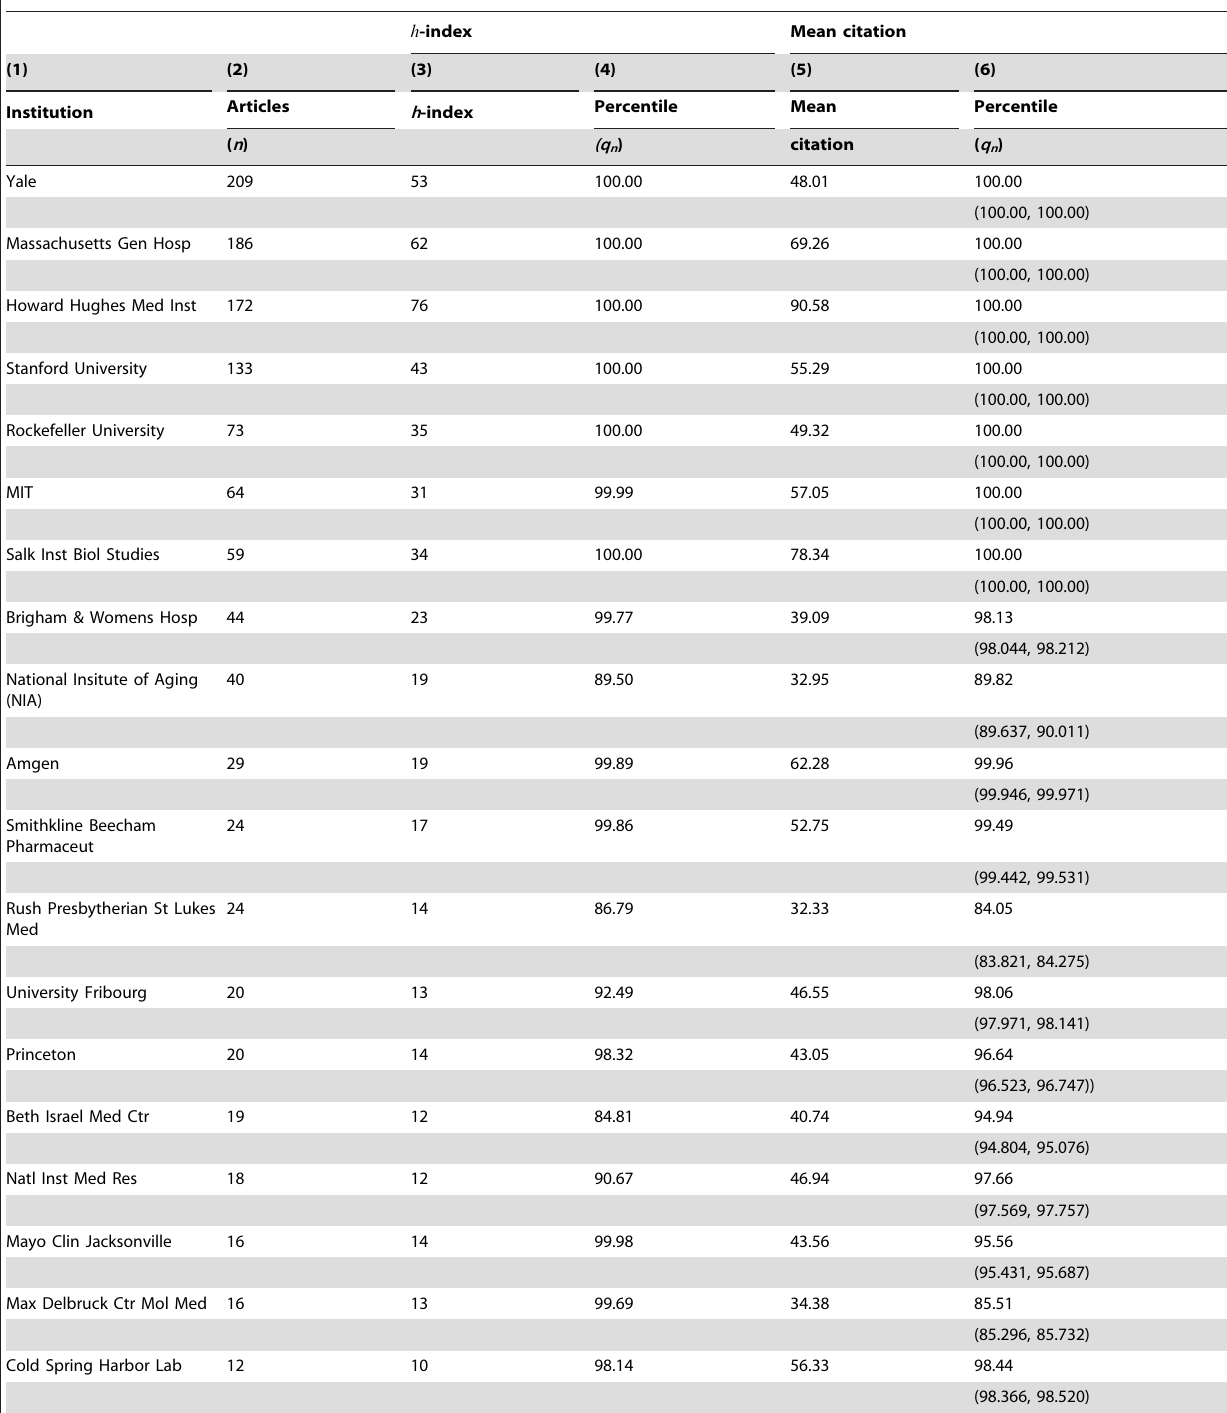
Table 3. Sub-field of